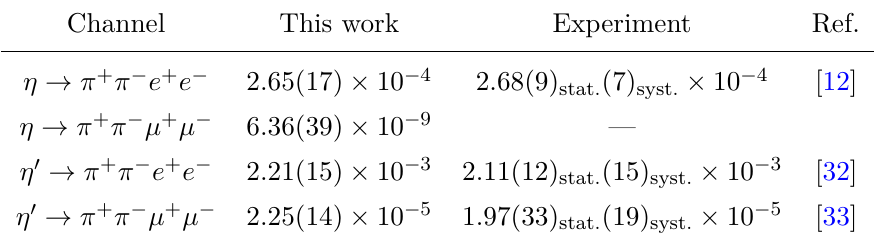
Table 1 . Branching ratios for the various η ( 0 ) → π + π − ‘ + ‘ − decay channels in the Standard Model. with β ( s ) = (1 − 4 M 2 /s ) 1 / 2 , that in addition ensures the appropriate asymptotic π ‘ ‘ π behavior in the kinematic region of